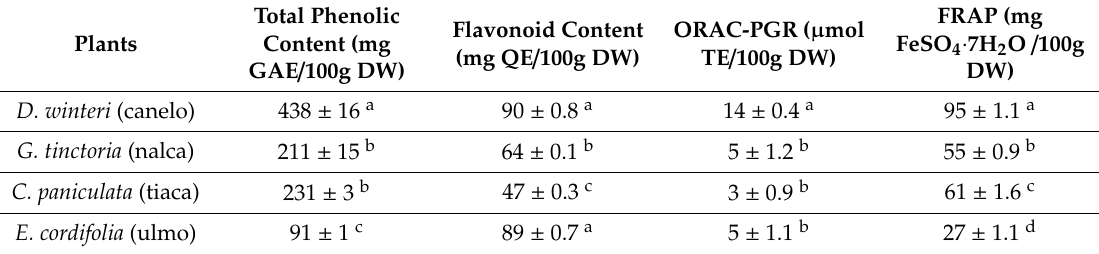
Table 1. Content of phenolic and flavonoid compounds, oxygen radical absorption capacity-red pyrogallol method (ORAC-PGR) and ferric ion reducing antioxidant power (FRAP) values in plant extracts.